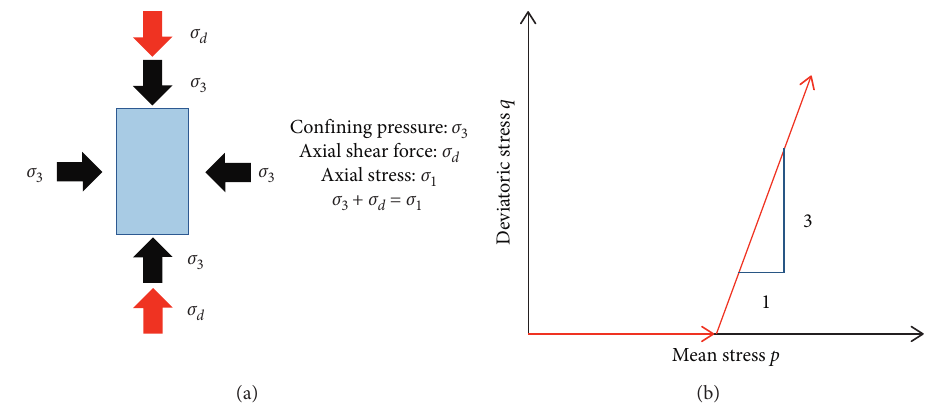
Figure 4: Schematic description of triaxial loading. (a) Triaxial compression test. (b) Stress